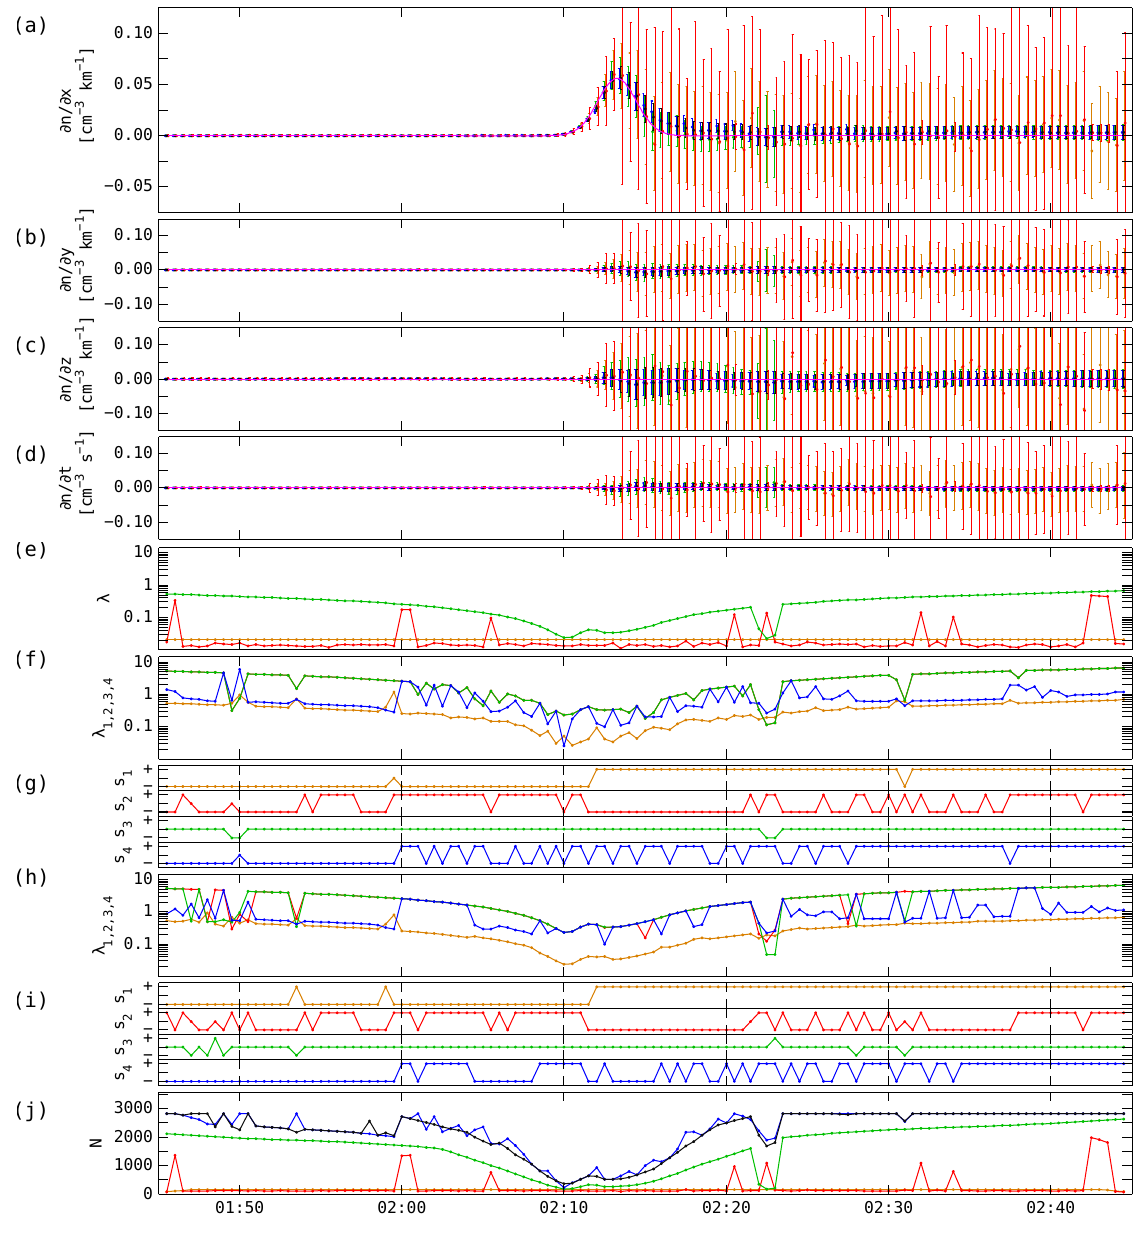
Fig. 7. Least-squares gradient at a density interface (4 spacecraft, small separation, 20% measurement error). See caption of Fig. 6. To facilitate comparison, the same axis scales have been used.